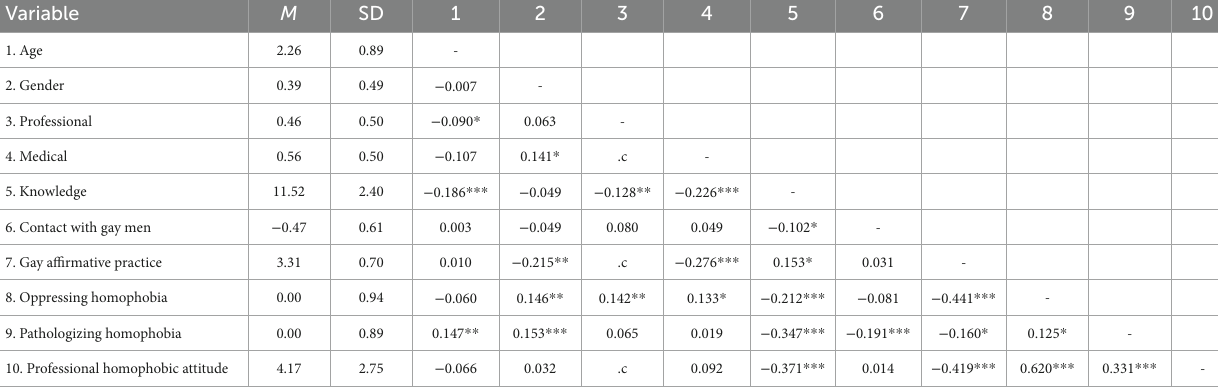
TABLE 5 Correlations between the characteristics of participants and homophobia.